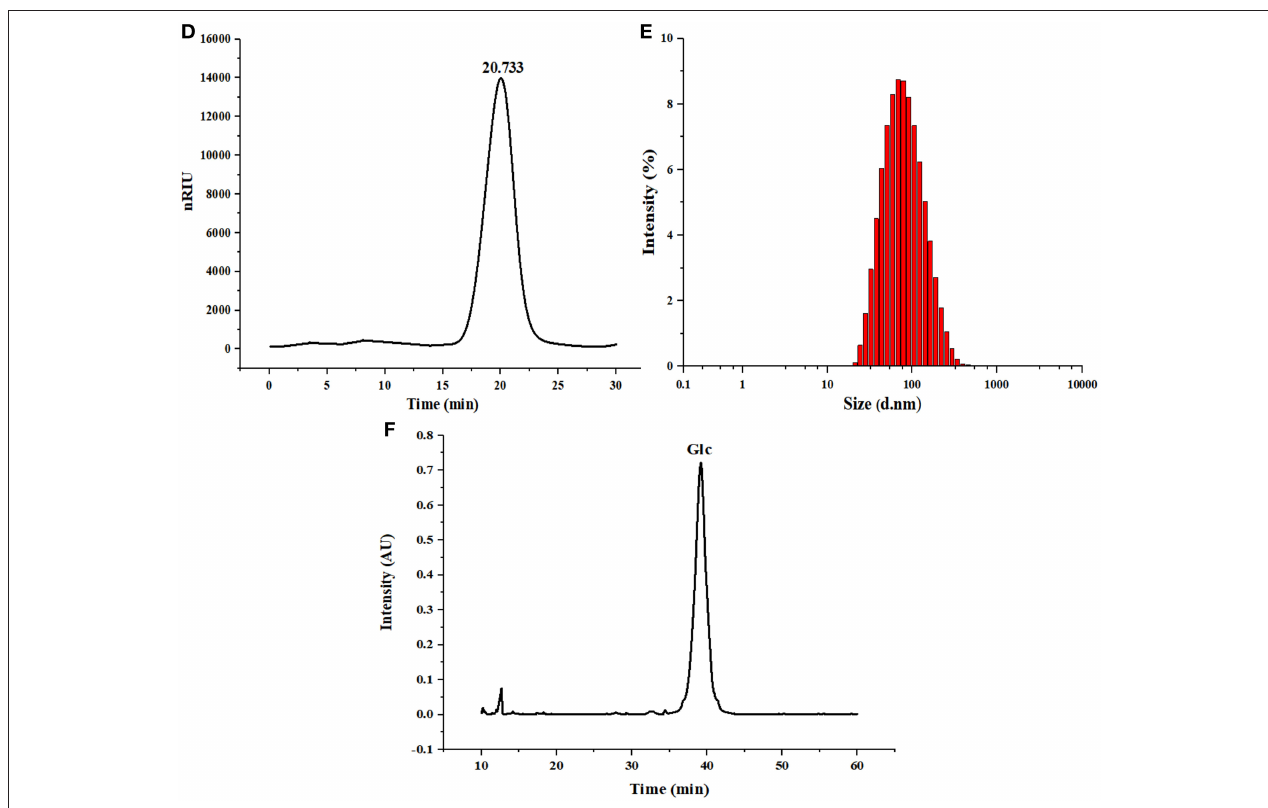
FIGURE 1 | Diagram of extraction process of Polygonatum sibiricum polysaccharide fraction 1 (PSP-1) (A) Chromatography of PSP-1 by DEAE-52 cellulose column (B) and Sephadex G-100 chromatography (C) HPGPC chromatograms of PSP-1 (D) Particle size distribution of PSP-1 (E) Monosaccharide composition of PSP-1 (F) .